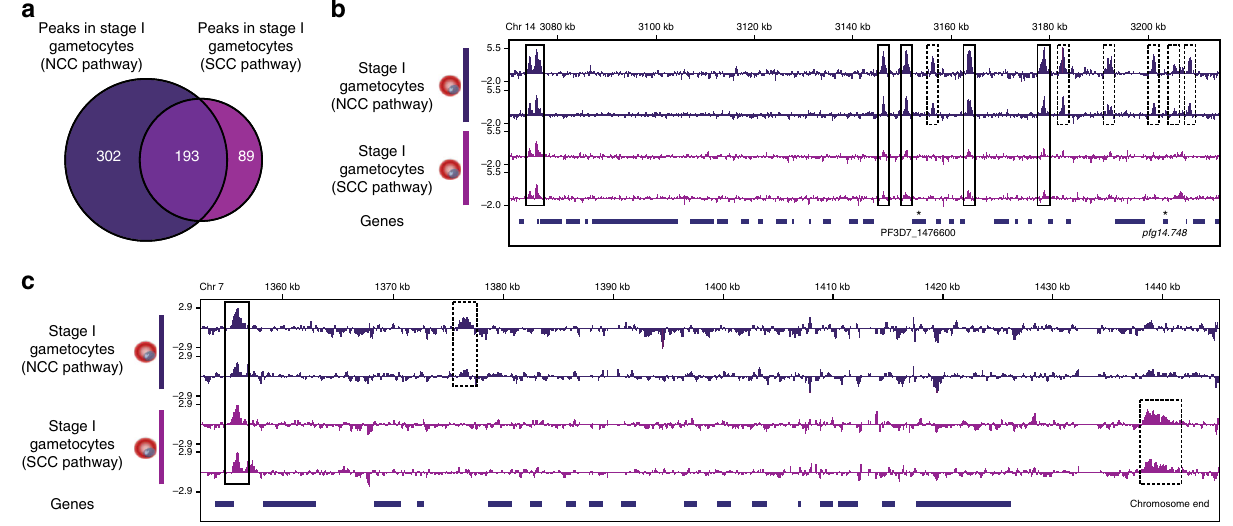
Fig. 2 Stage I gametocytes resulting from next cycle conversion (NCC) and same cycle conversion (SCC) have major differences in PfAP2-G occupancy. a Venn diagram showing that although PfAP2-G has many common targets in stage I gametocytes produced via next-cycle conversion and same-cycle conversion, there are also many differences. bandc, Log2-transformed PfAP2-G ChIP/input ratio tracks for stage I gametocytes derived via NCC (purple) and those derived via SCC (pink) across a region of chromosome 14 ( b ) and the end of chromosome 7 ( c ). The blue bars underneath show the locations of genes. Data are shown for each of two biological replicates per stage. Dashed boxes highlight stage-speci fi c binding sites and solid boxes indicate common binding sites. Asterisks in bindicate genes known to be more highly expressed in NCC gametocytes than in SCC driver of gametocytogenesis. PfAP2-G not only activates genes during the commitment phase but also up until at least stage I of gametocytogenesis. The identi fi cation of hundreds of PfAP2-G target genes provides insight into which genes are involved in the early stages of gametocytogenesis.